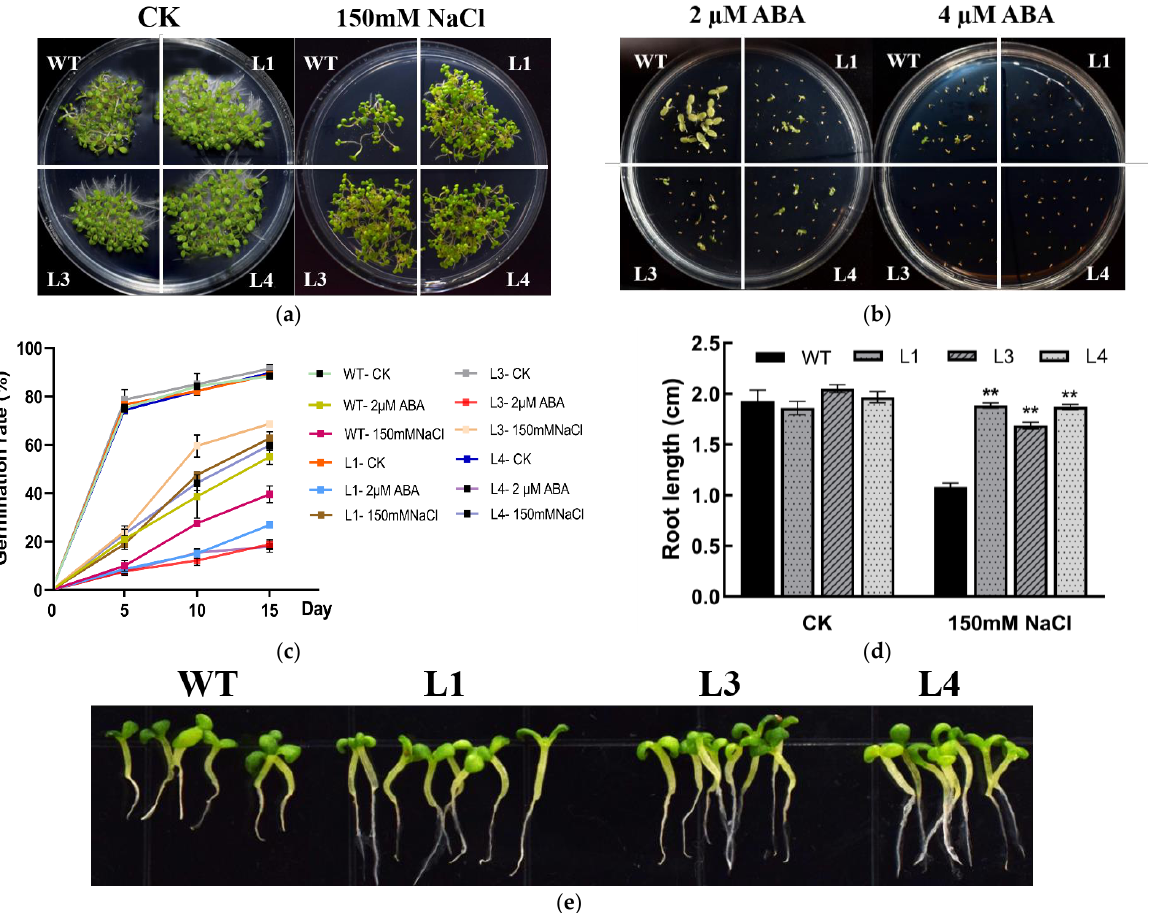
Figure 5. Overexpression of the LoSWEET14 gene improved salt stress resistance and ABA sensitivity of Nicotiana tabacum . WT and LoSWEET14 transgenic tobacco were sown on MS media containing 0 µM ABA/NaCl (CK), 150 mM NaCl ( a ), 2 µM ABA, 4 µM ABA ( b ), respectively. Germination rate of WT and transgenic tobacco seeds under different treatments ( c ), root length ( d ) and growth ( e ) of WT and transgenic tobacco treated with 150 mM NaCl were observed and measured 2 weeks after germination. Each value indicates Mean ± SE (standard error). Asterisks indicate a significant difference ** p < 0.01 compared with the corresponding